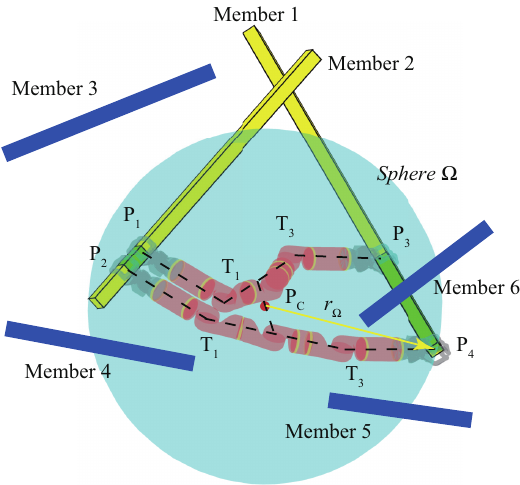
Figure 9. The method to extract potential obstacles when transiting between adjacent